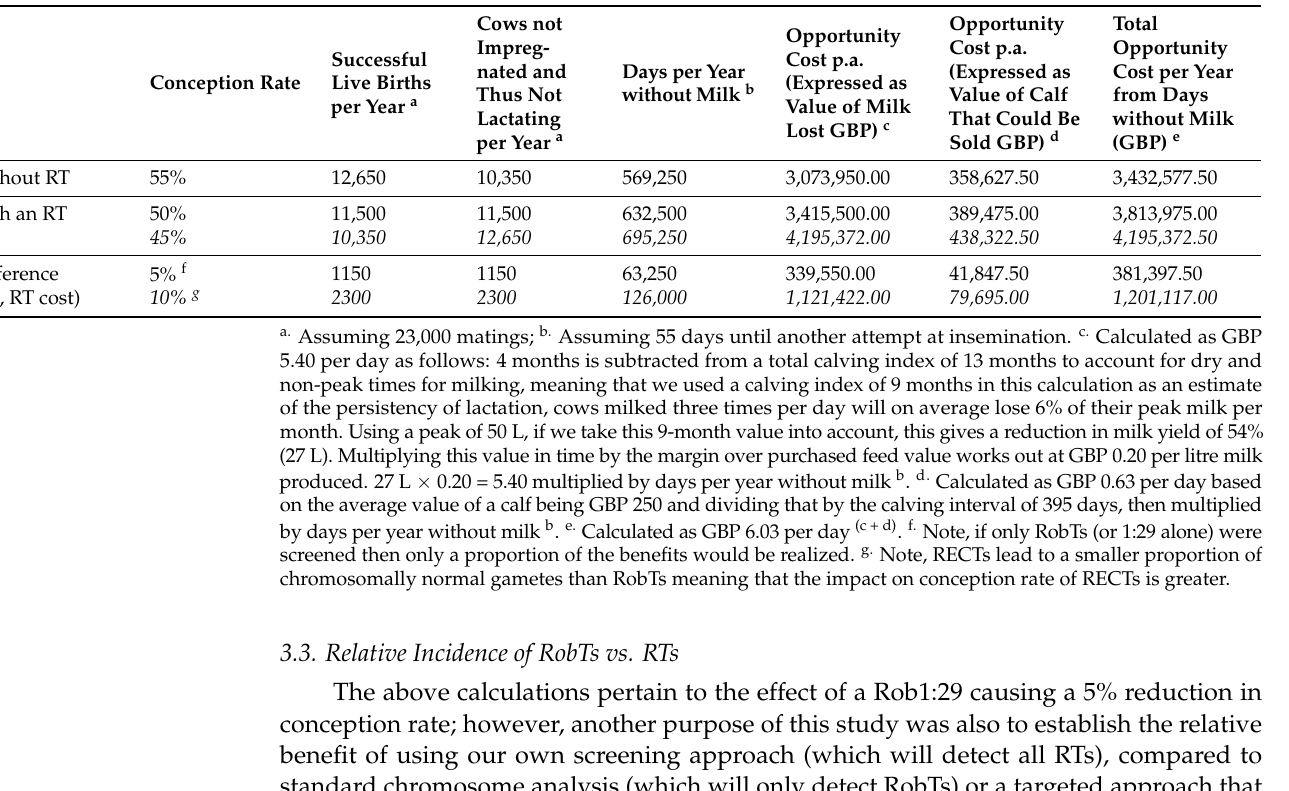
Table 2. Calculations leading to relative opportunity cost of a bull with an RT assuming 5% reduction in conception rate as reported for Rob1:29 [9,10] and 10% reduction in italics if all RTs are taken into